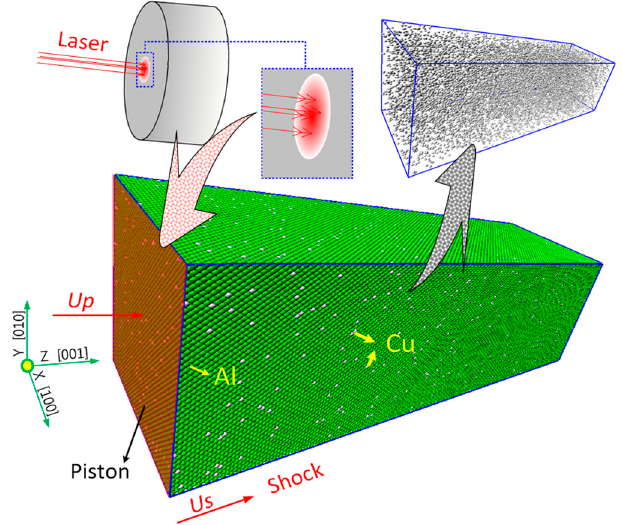
Figure 2. Molecular dynamics model of the Al-Cu alloy.